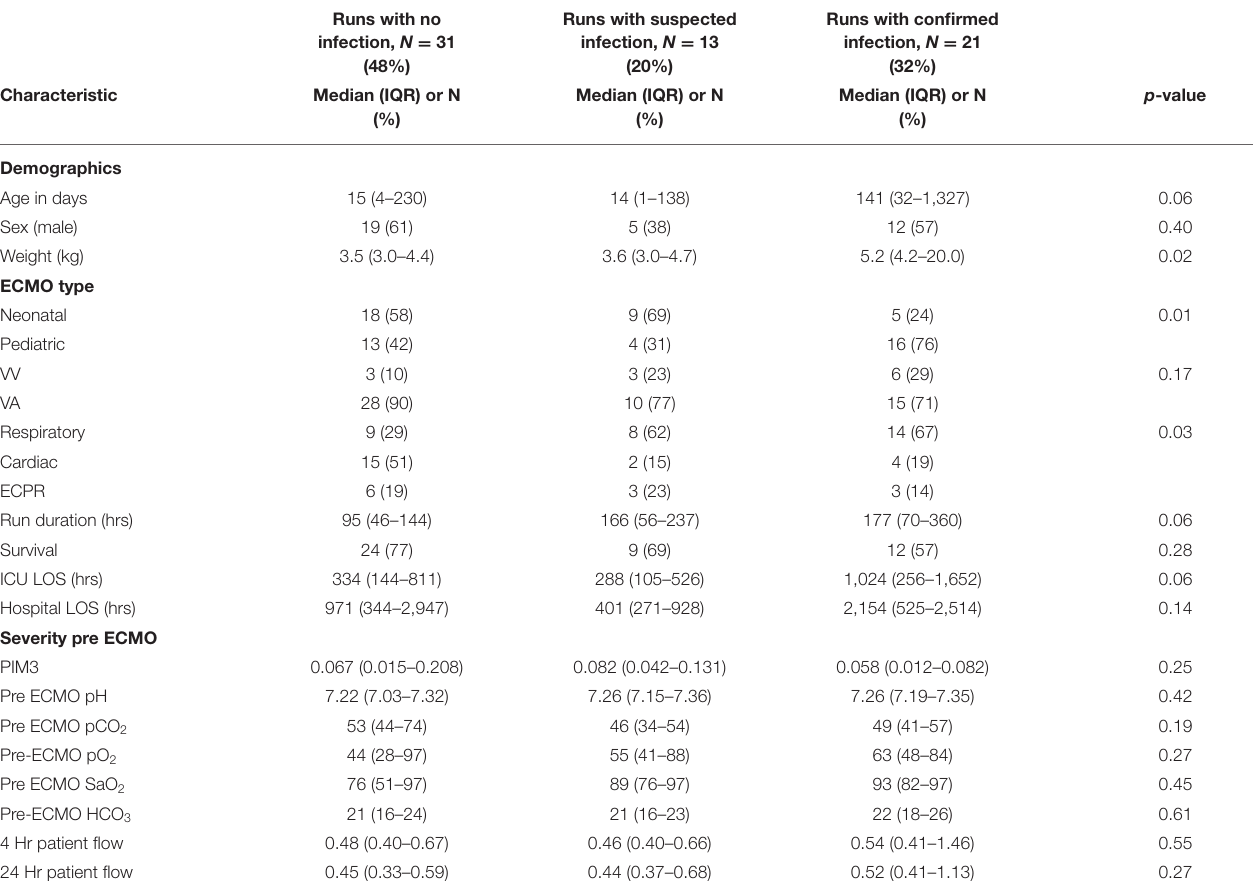
TABLE 1 | Baseline characteristic of patients, grouped into Extracorporeal Membrane Oxygenation (ECMO) runs with no infection, with suspected infection, and with confirmed infection.